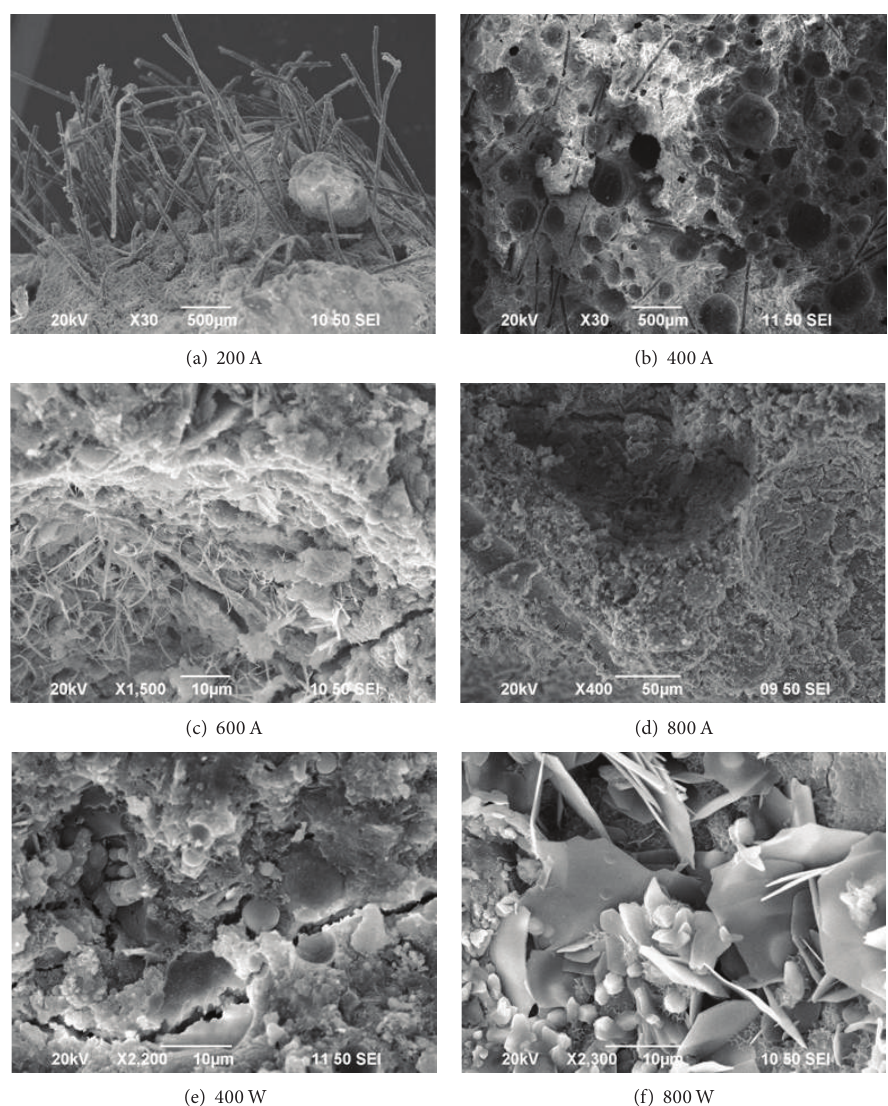
Figure 5: SEM micrograph of ECC specimens subjected to different heating temperatures and cooling